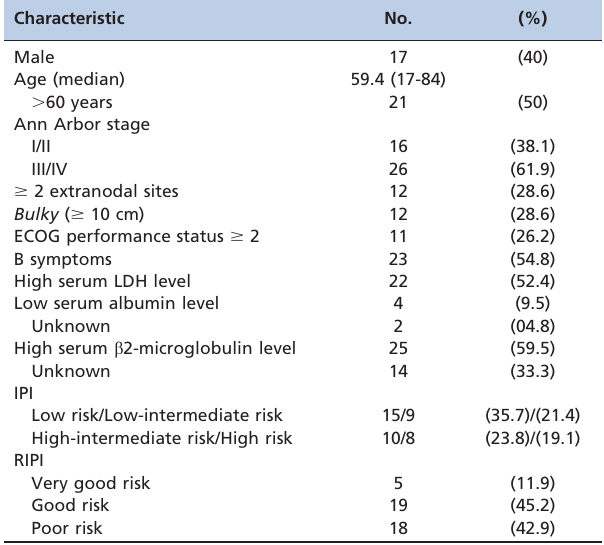
Table 1 - Characteristics of the cohort at